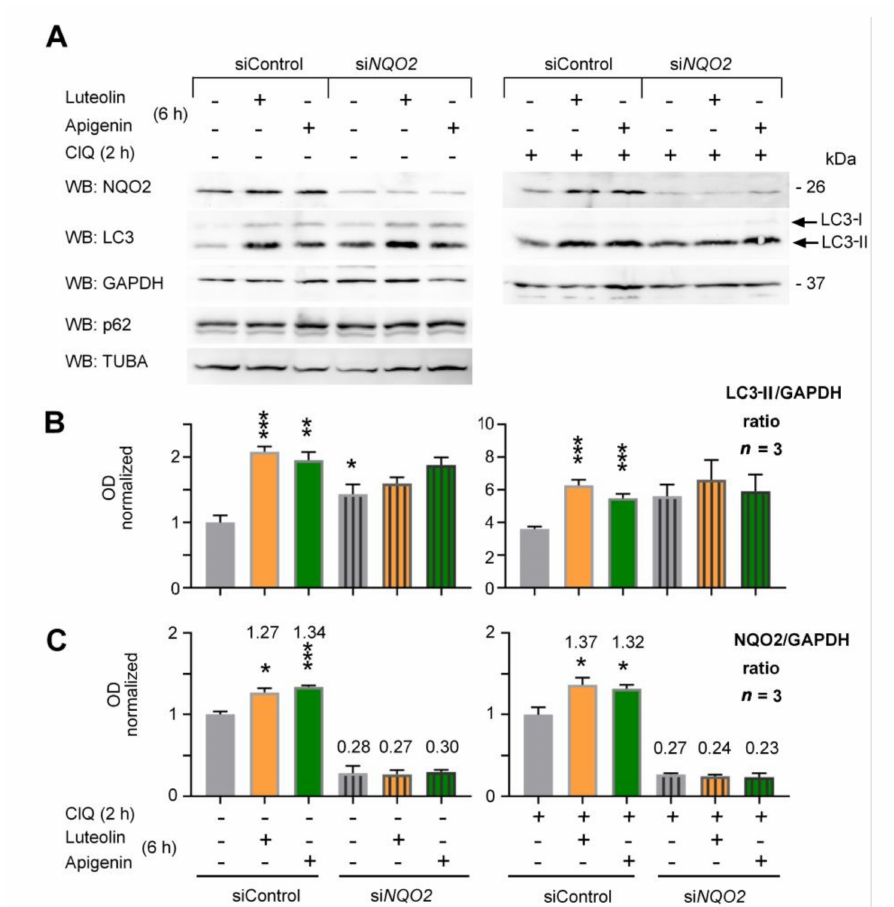
Figure 3. Silencing of NQO2 augments autophagic flux in HepG2 cells and reduces the response to luteolin and apigenin. ( A ) HepG2 cells were transfected with a control siRNA and NQO2-specific siRNA, which were treated as indicated for 6 h (luteolin, apigenin 10 g/mL) and analyzed by WB (SDS-PAGE 12%) for the expression of NQO2 and LC3. GAPDH was used as loading control. ( B , C ) The graphs show the OD analysis of LC3-II ( B ) and NQO2 ( C ) (ratio to GAPDH, normalized to vehicle-treated controls) of the experiment described in ( A ) as means +/ − SEM of three blots from n = 3 independent experiments, each analyzed at two different exposures. Statistical analysis: Brown– Forsythe and Welch ANOVA followed by Tamhane’s T2 test; * p < 0.05, ** p < 0.01, *** p <